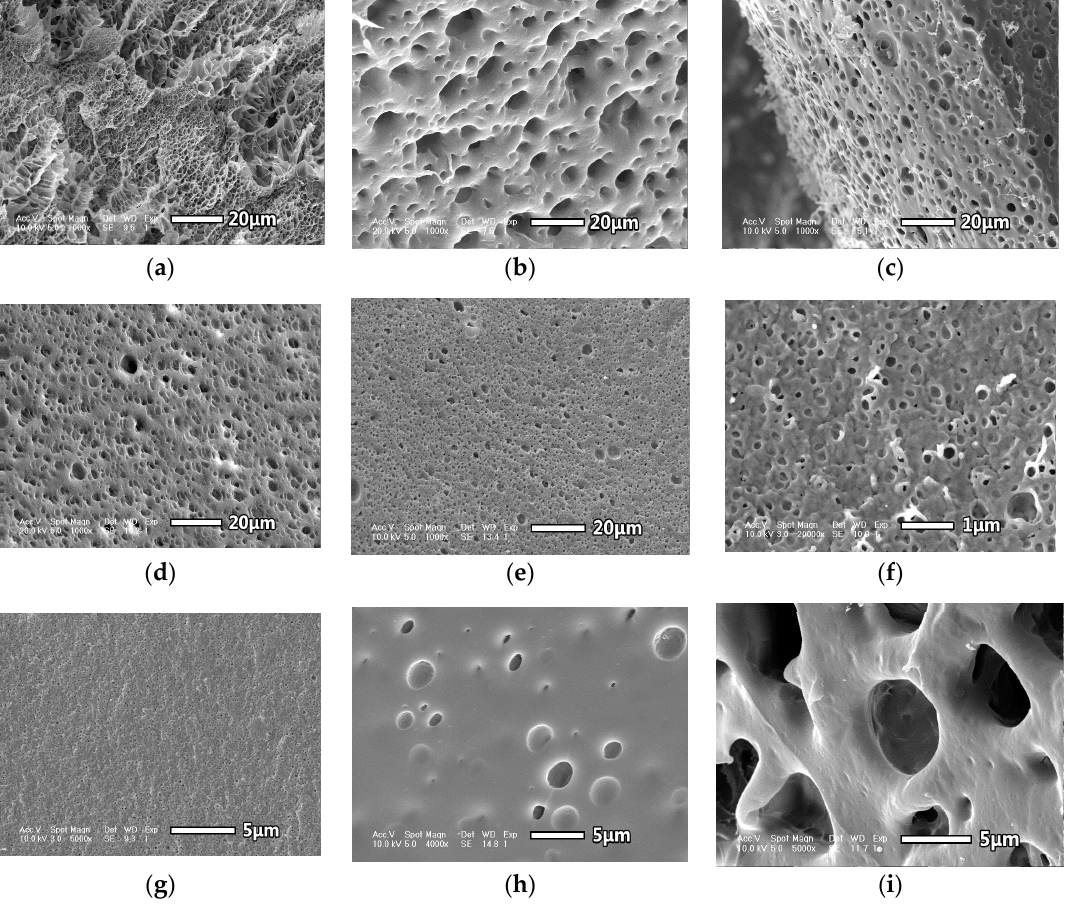
Figure 3. SEM images of ( a ) Gel 1; ( b ) Gel 2; ( c ) Gel 3; ( d ) Gel 4; ( e ) Gel 5; ( f , g ) Gel 6; ( h ) Gel 7; and ( i ) Gel 8.